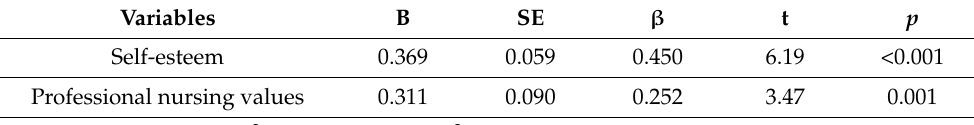
Table 5. Factors that affect career identity ( N = 140).